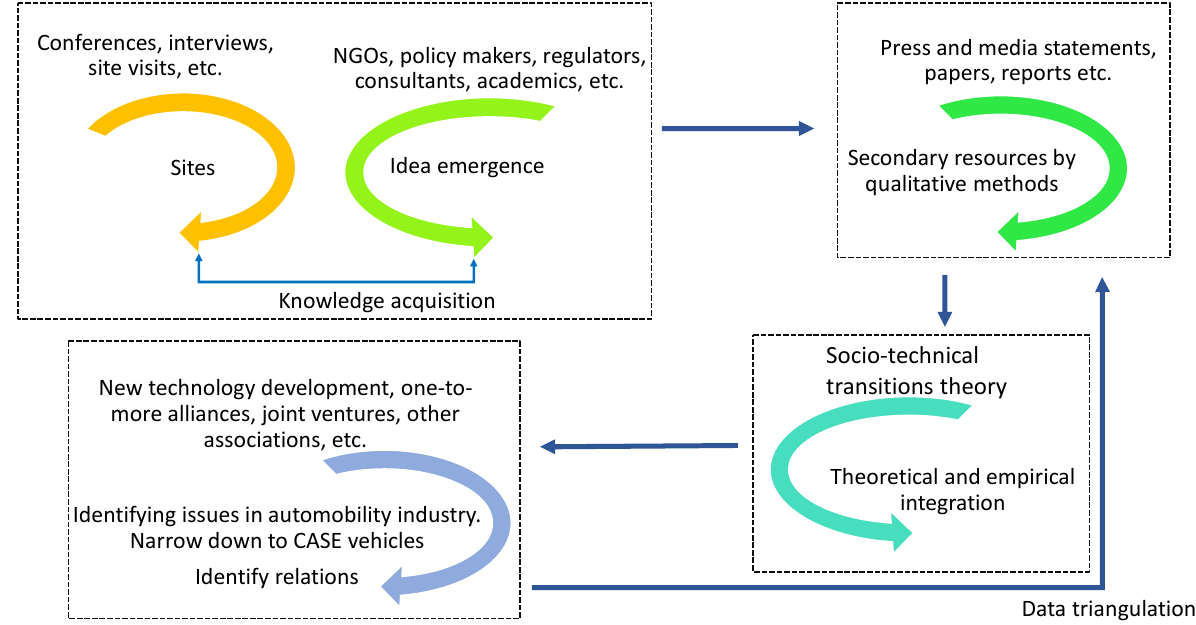
Figure 2. Research method flow.